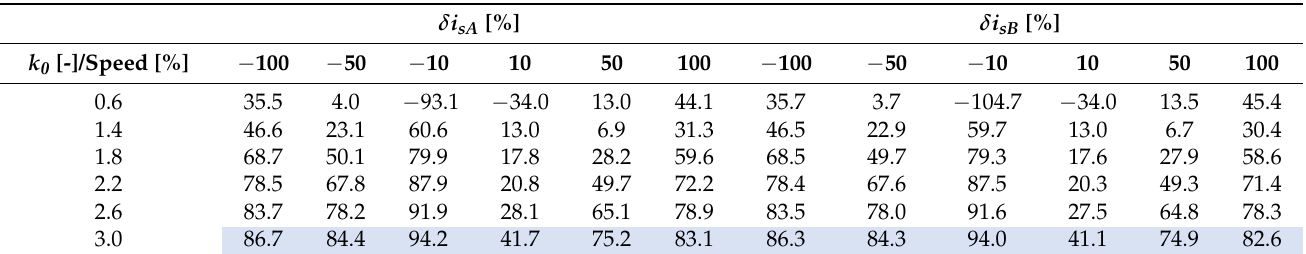
Table 2. Decrease in MLO sensitivity to changes in IM parameters relative to OLO, for two healthy CSs (grey color indicates the best